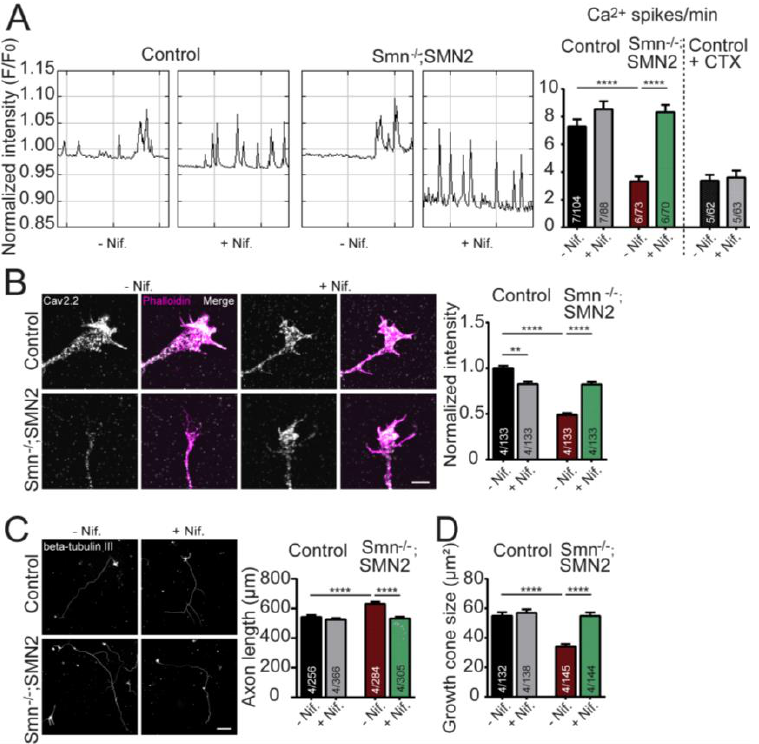
Figure 1. Nifedipine increases the frequency of Ca 2+ transients and improves Cav2.2 cluster-like for- mation at the growth cones of embryonic motor neurons cultured on laminin-221/211. ( A ) Repre- sentative plots of Oregon Green™ 488 BAPTA-1 fluorescent changes over time, indicating sponta- neous Ca 2+ spikes of control and SMN −/− ;SMN2 +/+ motor neurons untreated and treated with nifedi- pine (+Nif.). Quantification of spontaneous Ca 2+ spikes per min in control and SMN −/− ; SMN2 +/+ growth cones untreated and Nif. treated, as well as control growth cones that were additionally treated with ω-Conotoxin MVIIA (CTX) (ANOVA Kruskal–Wallis, **** p ≤ 0.0001). ( B ) Growth cones from control and SMN −/− ;SMN2 +/+ motor neurons untreated and Nif. treated, stained against Cav2.2 (gray) and F-actin (Phalloidin, magenta). Normalized mean gray values of Cav2.2 (ANOVA Krus- kal–Wallis, ** p ≤ 0.01; ****; p ≤ 0.0001). Scale bar: 5 µM. ( C ) Motor neurons from control and SMN −/− ;SMN2 +/+ mice untreated and treated with Nif., stained against β-tubulin III (gray). Scale bar: 100 µM. Nif. treatment in SMN −/− ;SMN2 +/+ motor neurons rescued axon length (control: 542.7 ± 12.4 µm; control + Nif.: 524.6 ± 9.9 µm; SMN −/− ;SMN2 +/+ : 631.7 ± 13.5 µm; SMN −/− ;SMN2 +/+ + Nif.: 532.3 ± 12.1 µm; ANOVA Kruskal–Wallis test, **** p ≤ 0.0001). ( D ) Nif. treatment increases growth cone size in SMN-deficient motor neurons (control: 54.97 ± 2.42 µm 2 ; control + Nif.: 56.99 ± 2.37 µm 2 ; SMN −/− ;SMN2 +/+ : 34.07 ± 1.83 µm 2 ; SMN −/− ;SMN2 +/+ + Nif.: 54.95 ± 2.34 µm 2 ; ANOVA Kruskal–Wallis test, **** p ≤ 0.0001). Data are presented as bar plots. Bars represent the mean ± SEM. Groups are labeled as N/n where N is the number of independent experiments and n is the number of individual growth cones analyzed.